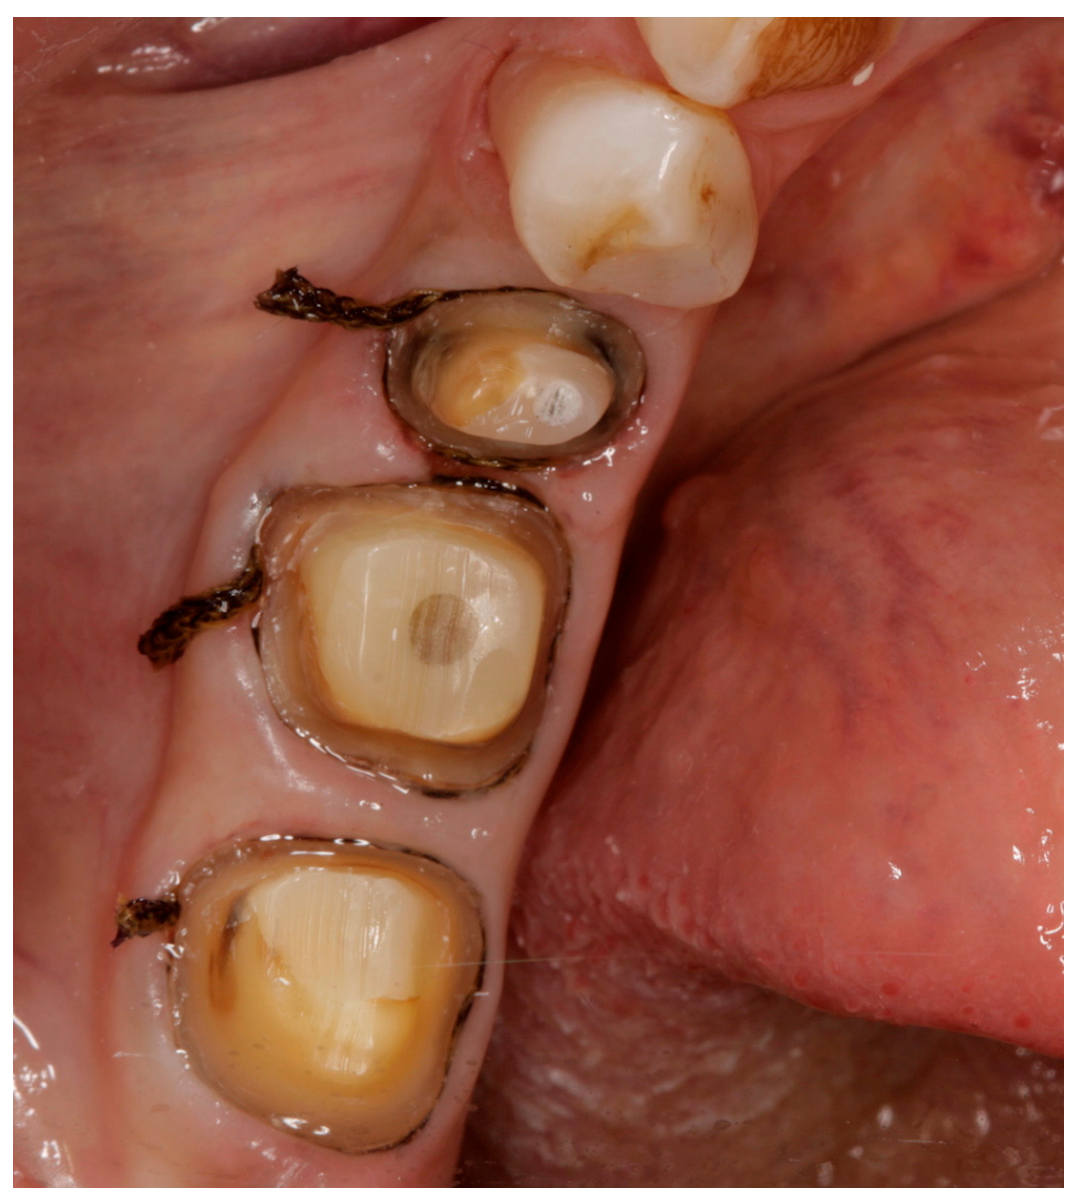
Figure 1. Impression technique for monolithic zirconia restorations. Only the second premolar was included in our study.